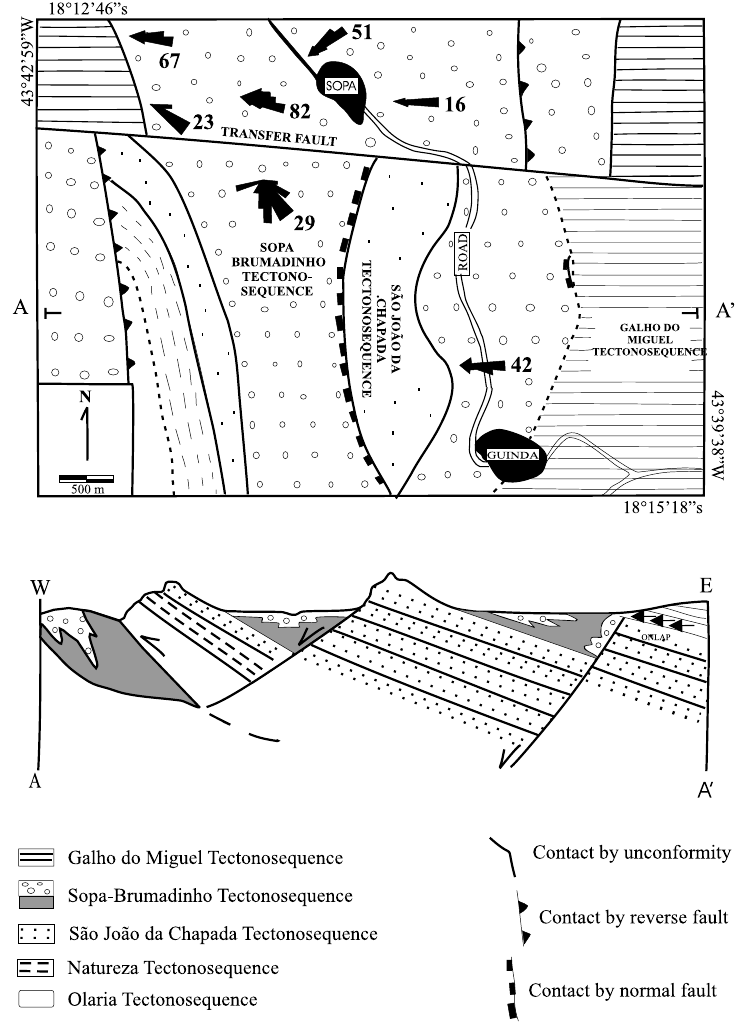
Fig. 4 – Geological map of the Espinhaço tectono-stratigraphic units of the central part of the Serra do Espinhaço (see Fig. 1 for location) showing paleocurrent rose diagrams (with numbers of measurements) for different localities, and a not-scaled cross-section (modified from Martins–Neto